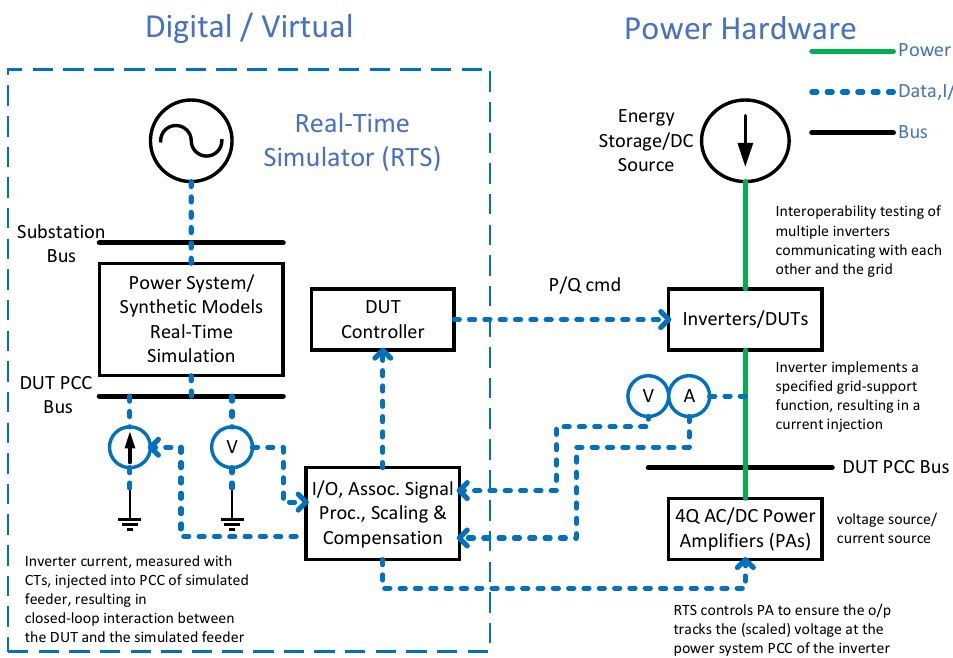
Figure 13. Diagram of an example PHIL testing platform to advance smart inverter-based grid-edge solutions illustrating three main parts: (1) RTS simulates the distribution feeders, (2) hardware setup with the power amplifier, inverter, and DC source, and (3) the interface I/O between the hardware setup and RTS.